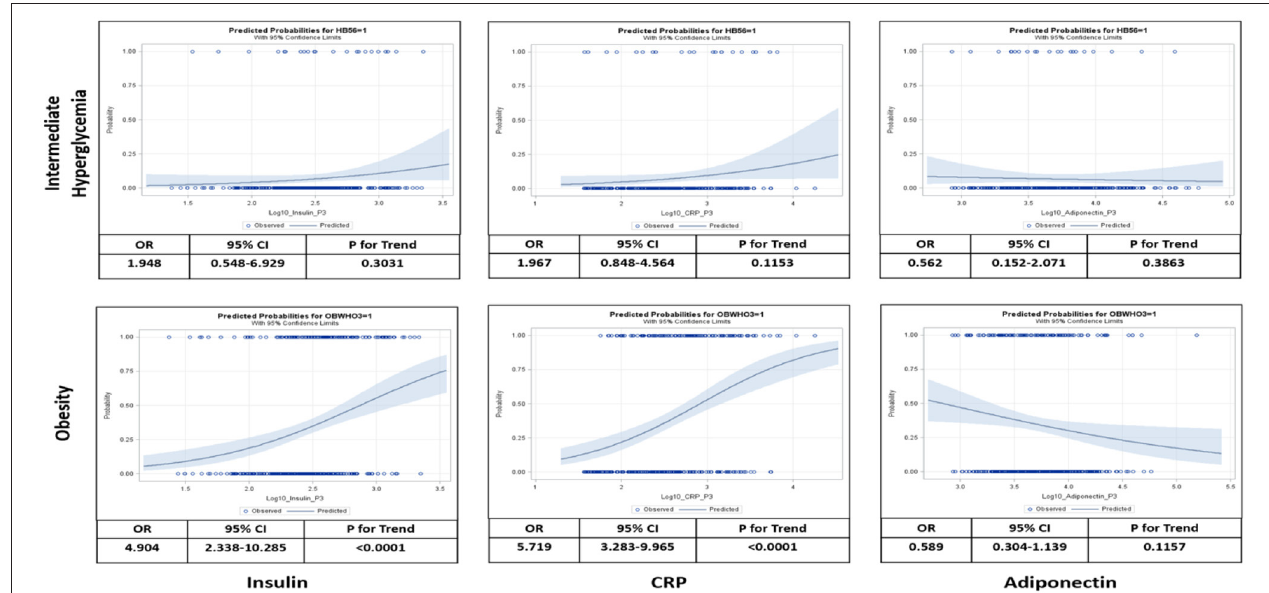
FIGURE 4 | Logistic analysis relating salivary levels of insulin, C-reactive protein (CRP), and adiponectin to probabilities of intermediate hyperglycemia and obesity at visit 3. Intermediate hyperglycemia was defined as hemoglobin A1c (HbA1c) between > 5.6– < 6.4% and obesity was defined as body mass index (BMI) >